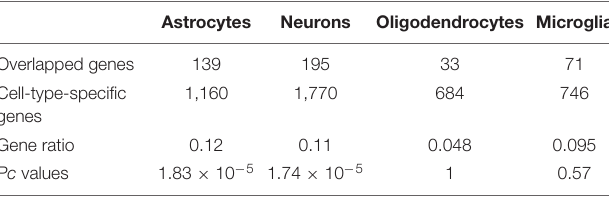
TABLE 3 | The significance of the overlap between PLS1- genes and cell-type-specific genes. Astrocytes